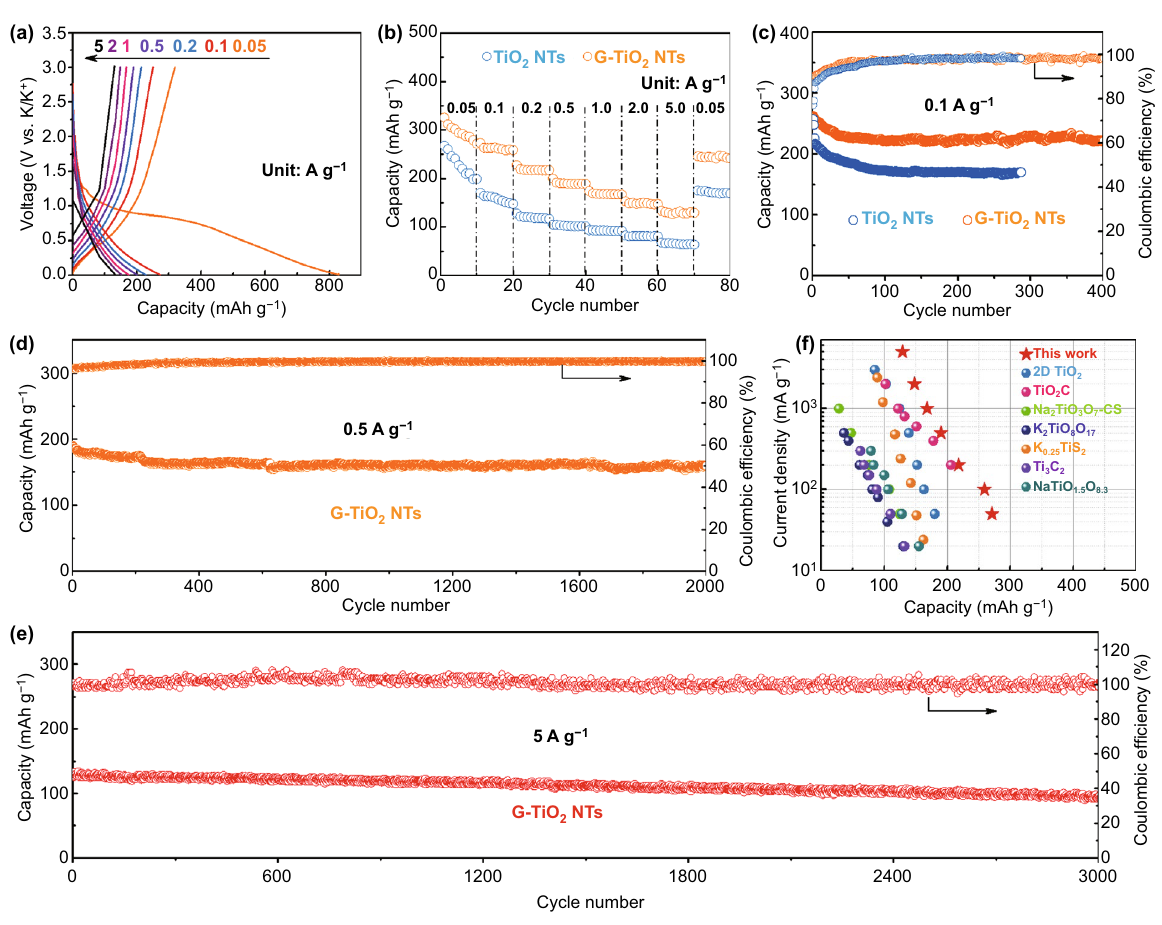
Fig. 2 Electrochemical performances of bare TiO 2 NTs and G‑TiO 2 NTs as anodes in KIBs. a Galvanostatic charge–discharge profiles of G‑TiO 2 NTs at various current densities of 0.05–5 A g −1 . b Rate performances of bare TiO 2 NTs and G‑TiO 2 NTs at various current densities of 0.05–5 A g −1 . c Cycling performances of bare TiO 2 NTs and G‑TiO 2 NTs at a current density of 0.1 A g −1 . d Cycling performance of G‑TiO 2 NTs at a current density of 0.5 A g −1 for 2000 cycles. e Cycling performance of G‑TiO 2 NTs at a current density of 5 A g −1 for 3000 cycles. f Comparison of the rate performances between our G‑TiO 2 NT anode and the state‑of‑the‑art Ti‑based KIB